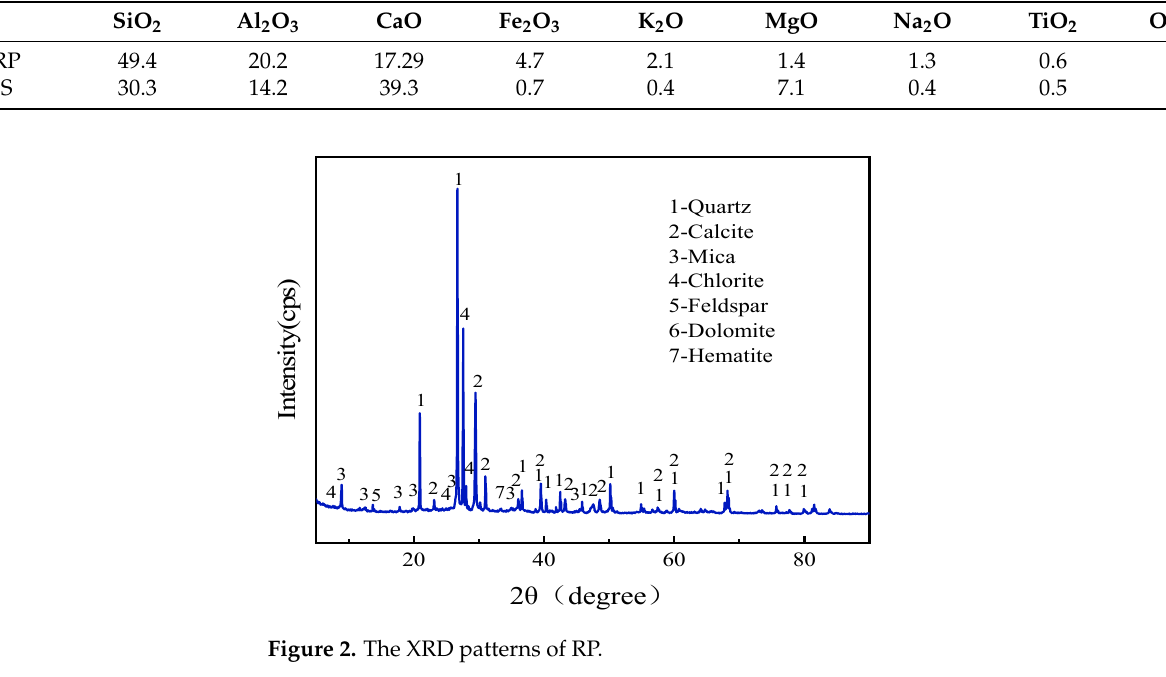
Figure 2. The XRD patterns of RP.